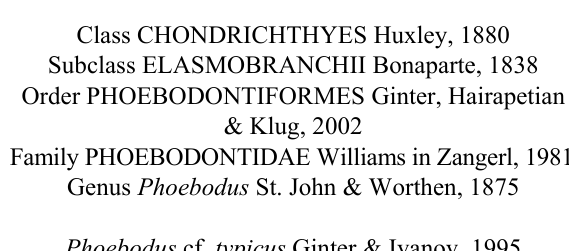
Fig. 2. Teeth of Phoebodus , Cladodoides and Karksiodus from the Devonian and Carboniferous of Belarus. A – C , Phoebodus cf. typicus Ginter & Ivanov, 1995. A, SPCG 106/49-3, occlusal view, Turov-5 core, depth 2042.2 m, sample 49, Lower Famennian, Kuzmichi Regional Stage; B, SPCG 70/4-1, occlusal view, Knyshevichi-7 core, depth 1989.9 m, sample 4, Lower Famennian, Petrikov Regional Stage; C, SPCG 95/16a-1, lingual view, Glusk-1 core, depth 1347–1351 m, sample 16 а , Lower Famennian, Petrikov Regional Stage. D – F , Phoebodus turnerae Ginter & Ivanov, 1992. D, E, SPCG 97/1a-1, occlusal and lingual views, Brinev-6 core, depth 446.7 m, sample 1a, Lower Famennian, Petrikov Regional Stage; F, SPCG 101/10-3, occlusal view, Krasnoselskaya-215 core, depth 3176–3184 m, sample 16a, Lower Famennian, Petrikov Regional Stage. G , Phoebodus sp., SPCG 99/27-1, occlusal view, Ostashkovichi-2R core, depth 2637–2641 m, sample 27, Lower Famennian, Drozdy Regional Stage. H – M , Cladodoides cf. wildungensis (Jaekel, 1921). H, I, K–M, 331 core, depth 292.2 m, sample 16a, Lower Tournaisian, Malevka Regional Stage; H, I, PM SPU 82-1, occlusal and labial views; K, L, PM SPU 82-3, occlusal and lingual views; M, PM SPU 82-4, oblique basal view; J, PM SPU 82-2, lingual view, 441 core, depth 304–307 m, sample 30v, Lower Tournaisian, Malevka Regional Stage. N , O , Karksiodus mirus Ivanov & Märss, 2011; Lepel-1 core, depth 194 m, sample 19, Eifelian, Kostyukovichi Regional Stage. N, SPCG 47/19-26, oblique basal view; O, SPCG 47/19-26a, occlusal view. Scale bars A–C, F, G, O – 100 µm; D, E, H–N – 500